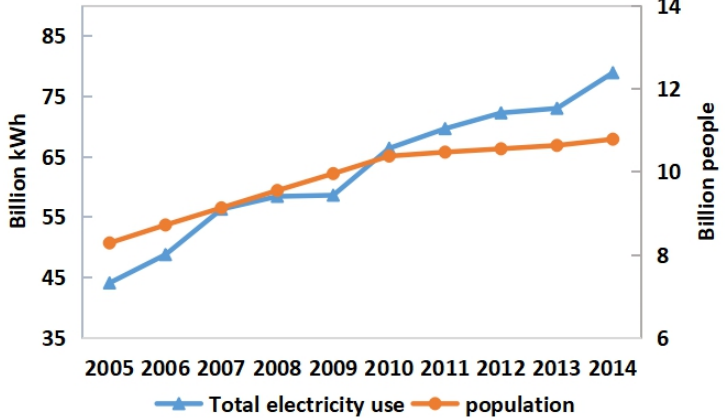
Figure 5. Relationship between population and total electricity use in Shenzhen during 2005–2014.